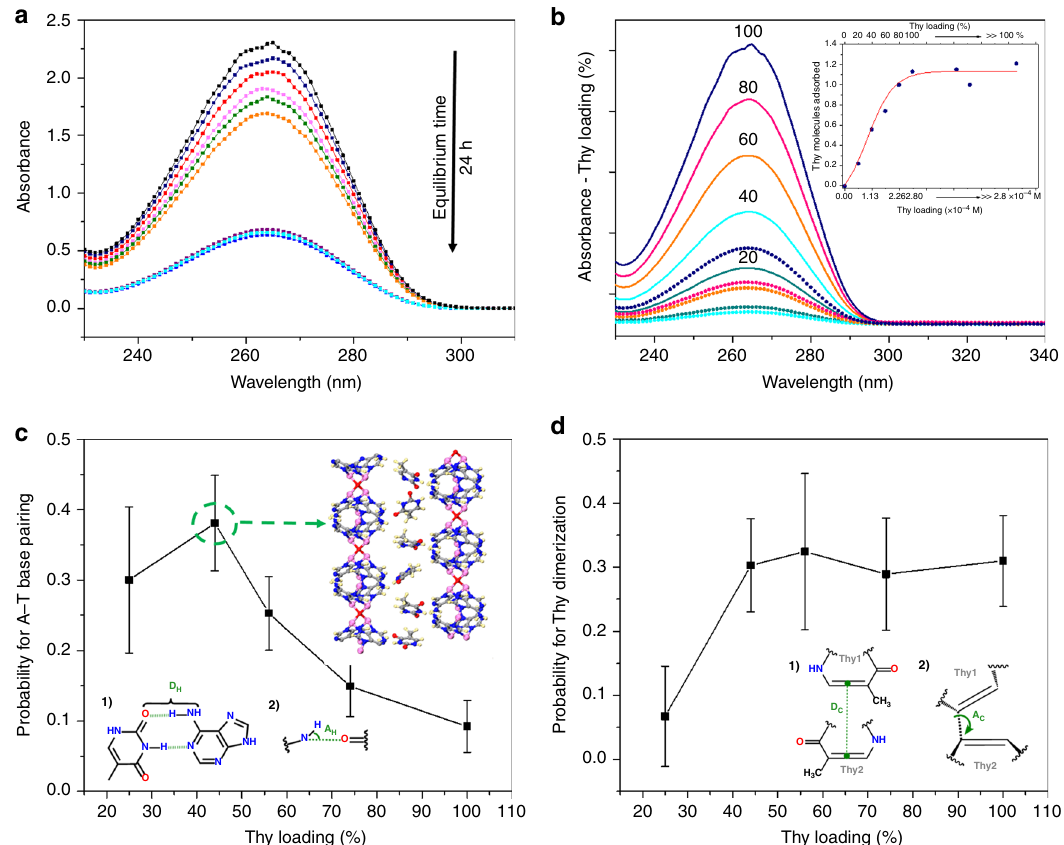
Fig. 3 Solution thymine isotherms in SION-19 ′ and probability of adenine – thymine pairing and thymine-dimerization. a Time dependency for Thy to reach equilibrium when loaded into SION-19 ′ . b Solution isotherms of 20 – 100% (0.56 – 2.80 × 10 − 4 M) Thy loaded into the pores of SION-19 ′ . Inset: maximum uptake of Thy (~1.1 molecules). Here, multiple Thy concentrations (blue circles — above 100% loading) were used to determine the saturation limit of Thy into the pores of SION-19 ′ . c Frequency of observed Ade – Thy base pair formation from MD simulations — Insets (1) and (2) show the metrics used for H-bonding formation between Ade – Thy from the MD simulations. d The frequency in which Woodward – Hoffmann and Schmidt rules are satis fi ed for Thy dimerization in the MD simulations at different loadings. Insets (1) and (2) show the metrics used for satisfying the Woodward – Hoffmann and Schmidt